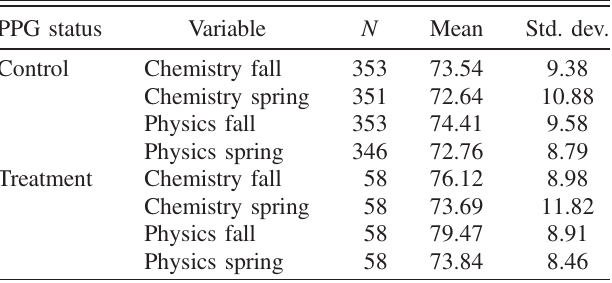
TABLE IV. Descriptive statistics for students with both chem- istry and physics data.